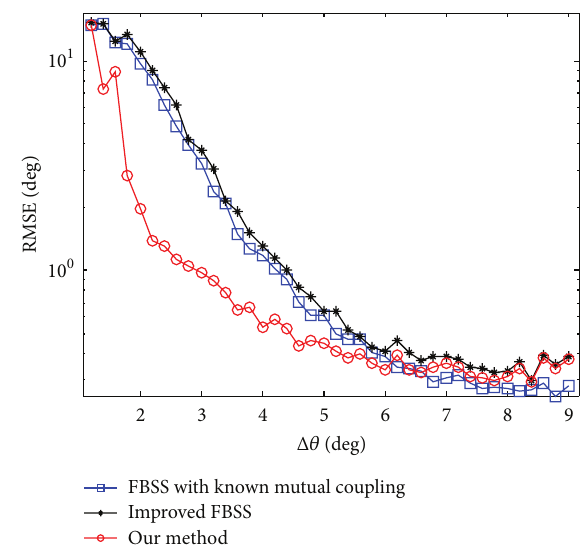
Figure 3: The RMSE of DOA estimation versus the angle interval.